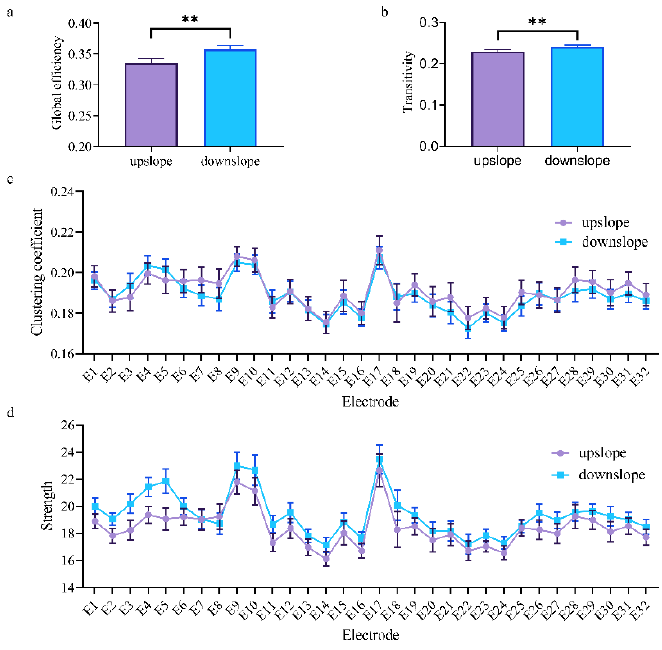
Figure 7. Indexes of the brain network for the two locomotion states in the beta band (13–30 Hz). ( a , b ) Global indexes of the brain network, including global efficiency and transitivity. ( c , d ) Local indexes of the brain network, including clustering coefficient and strength. All error bars indicate the 95% confidence interval of the mean. ** p ≤ 0.01.